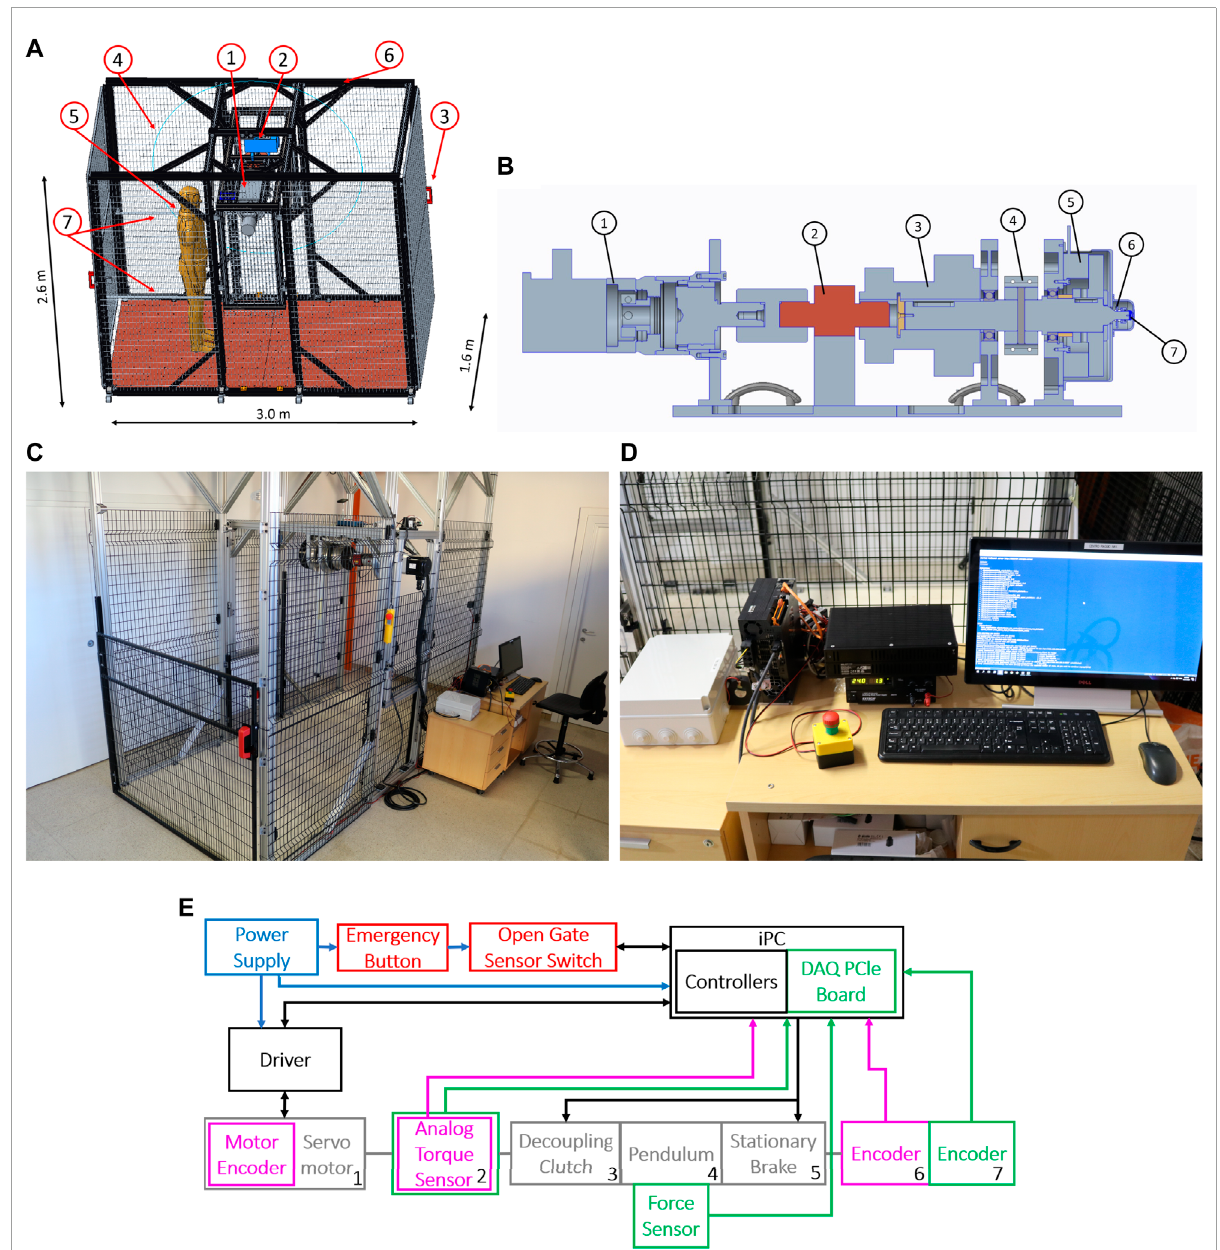
FIGURE 4 Photo of (A) Test-Bench dimensions and components: 1) Actuation group, 2) electrical crane, 3) sensorized safety doors, 4) safety panels, 5) agent positions during tests, 6) external structure, and 7) handrails. (B) Cross section of the actuation unit: From left to right, 1) servomotor, 2) torque sensor, 3) electro-magnetic clutch, 4) pendulum connector, 5) electro-magnetic brake, 6) first position sensor (absolute), 7) second position sensor (relative). (C) Testbed, and (D) industrial PC and controllers. (E) Electronic Connection of the Test-Bench. Blue arrows indicate the power connections, black arrows are the control communication network, and purple and green arrows describe sensor connections for the control loop and the data record. In red, we indicate the safety